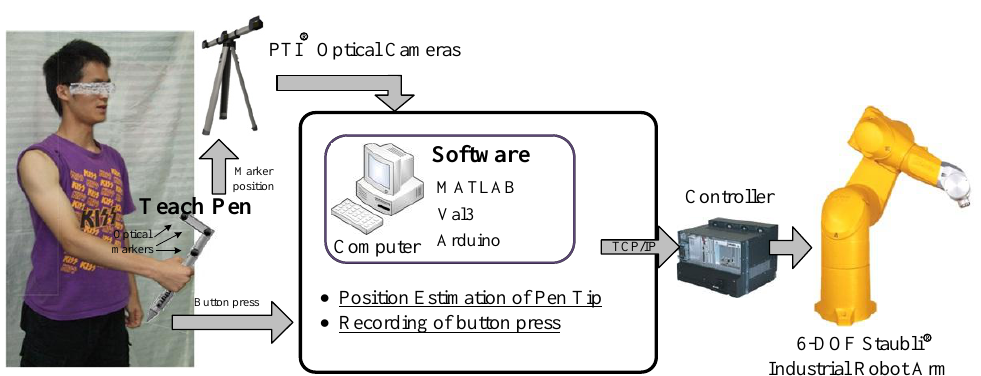
Figure 1. System